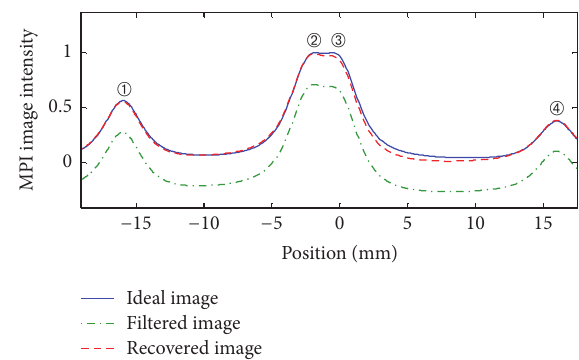
Figure 5: Normalized PSFs for particles with core diameters of 30 nm and 22 nm.